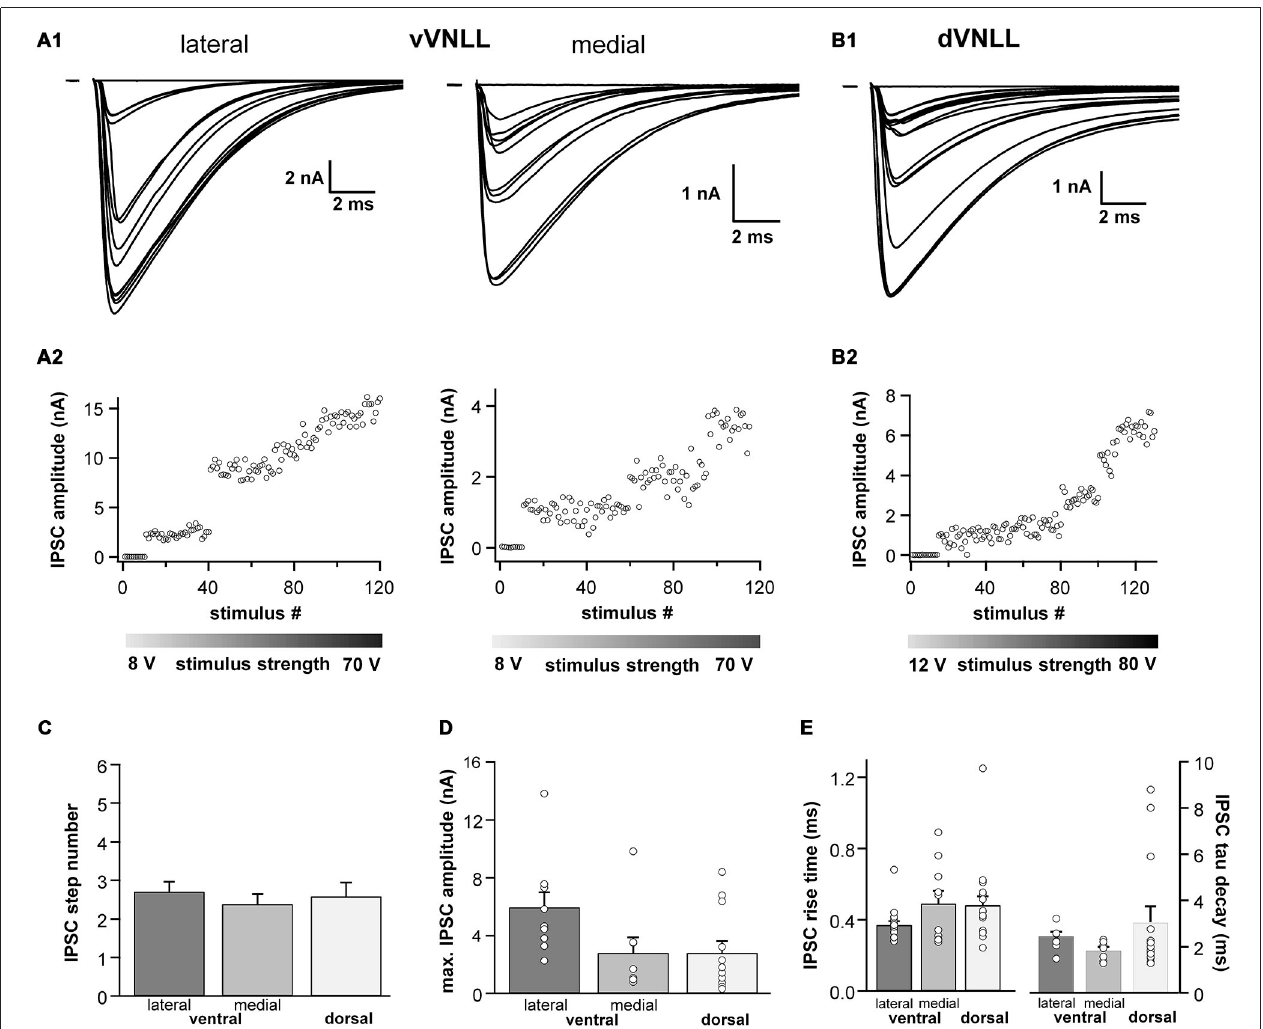
FIGURE 5 | Inhibitory inputs are similar in vVNLL and dVNLL neurons. (A1) Representative IPSC traces of ventrolateral (left) and ventromedial (right) VNLL neurons. Responses were evoked by increasing stimulation strength. Multiple inputs were found both in ventrolateral and ventromedial neurons. All traces represent the average of at least three consecutive recordings to the same stimulus strength. (A2) IPSC amplitude as a function of stimulus number recorded from the ventrolateral and ventromedial vVNLL neurons shown in (A1) . (B1) Representative IPSC traces of dVNLL neurons. Responses were evoked by increasing stimulation strength. This neuron shows four distinct current steps. All traces represent the average of at least three consecutive recordings to the same stimulus strength. (B2) IPSC amplitude as a function of stimulus number recorded from the dVNLL neuron shown in (B1) . Multiple current steps can be seen. (C) Number of IPSC steps evoked by increasing stimulation strength in vVNLL and dVNLL neurons. VNLL neurons receive two to three inputs. vVNLL: lateral n = 10, medial n = 8; dVNLL n = 12. (D) Maximal IPSC amplitude is similar in all VNLL regions. vVNLL: lateral n = 10, medial n = 8; dVNLL n = 12. (E) Rise time and tau decay time were measured in vVNLL and dVNLL neurons applying a minimal stimulation paradigm. vVNLL: lateral: n = 16; medial: n = 10; dVNLL: n = 14. Data are obtained from 16 C57/Bl6J